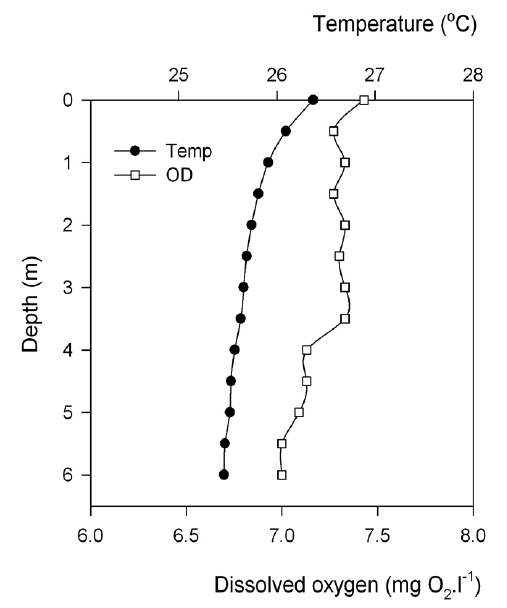
Figure 3. Vertical profiles of temperature (°C) and dis- solved oxygen (mg O